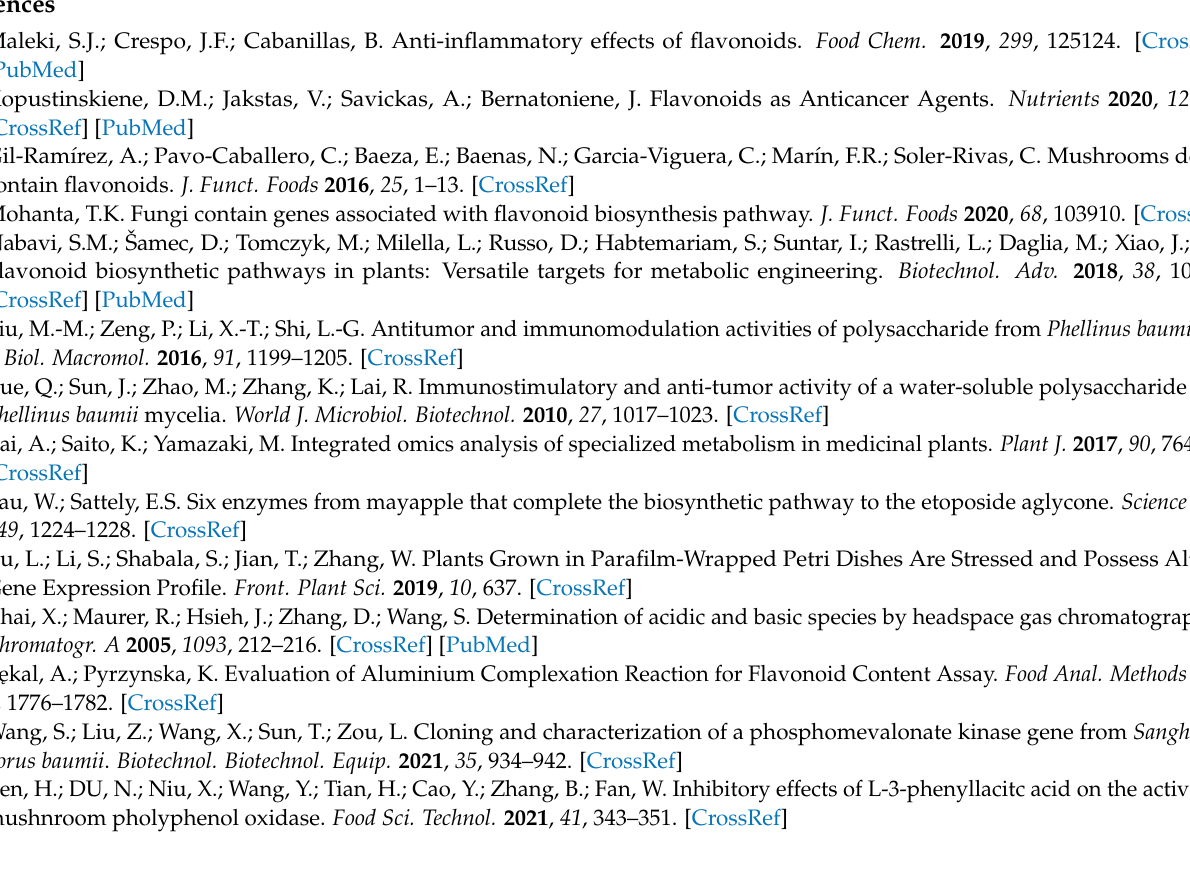
Figure S3: PCR gel electrophoresis results for the resistant strains (M: marker; N: negative